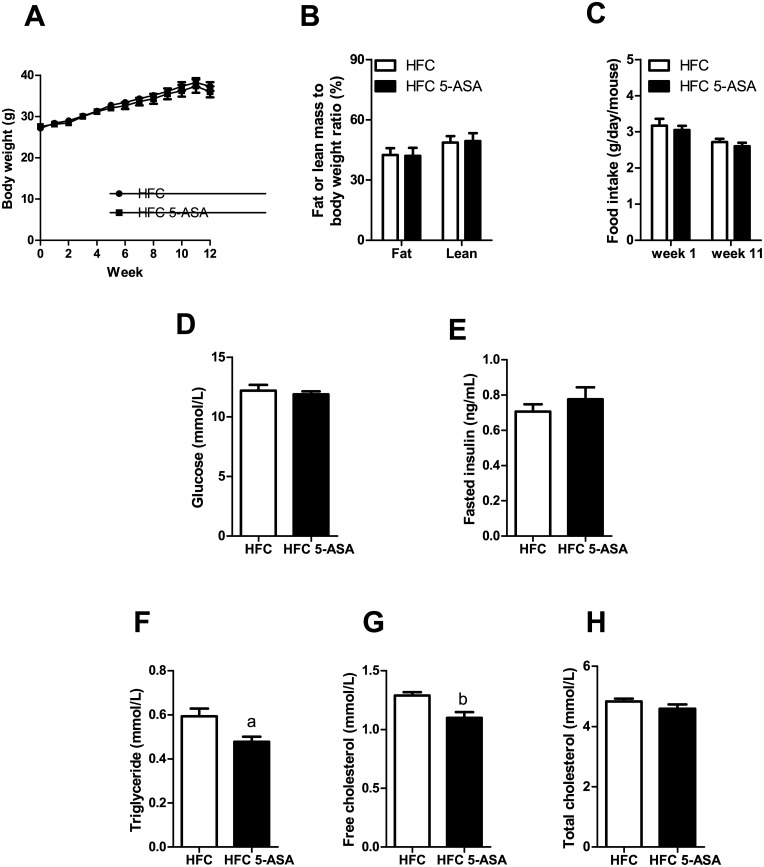
5-ASA treatment attenuates plasma lipid levels in HFC-fed mice.(A) Body weights of HFC and HFC 5-ASA-fed C57BL/6J mice over time, starting at 10–12 weeks of age. (B) Fat or lean mass to body weight ratio were assessed after 12 weeks of HFC or HFC 5-ASA. (C) Food intake of mice fed HFC and HFC 5-ASA at the first week and week 11. (D-E) Fasting glucose and fasting insulin of mice after 11 weeks of HFC or HFC 5-ASA. (F-H) Plasma triglycerides, free cholesterol and total cholesterol levels of 12-weeks HFC or HFC 5-ASA-fed mice. Data are presented as means ± SEM, n = 9–10 mice, aP < 0.05 vs. HFC, bP < 0.01 vs. HFC.